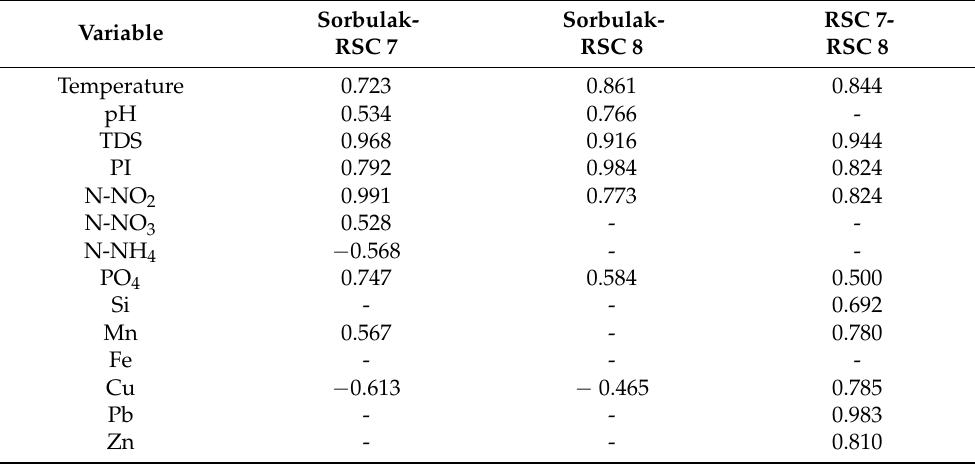
Table 2. Pearson’s correlation coefficients between seasonal variability of environmental variables in wastewater reservoirs of the Right-Bank Sorbulak Canal system, 2021, at p < 0.05. Variable